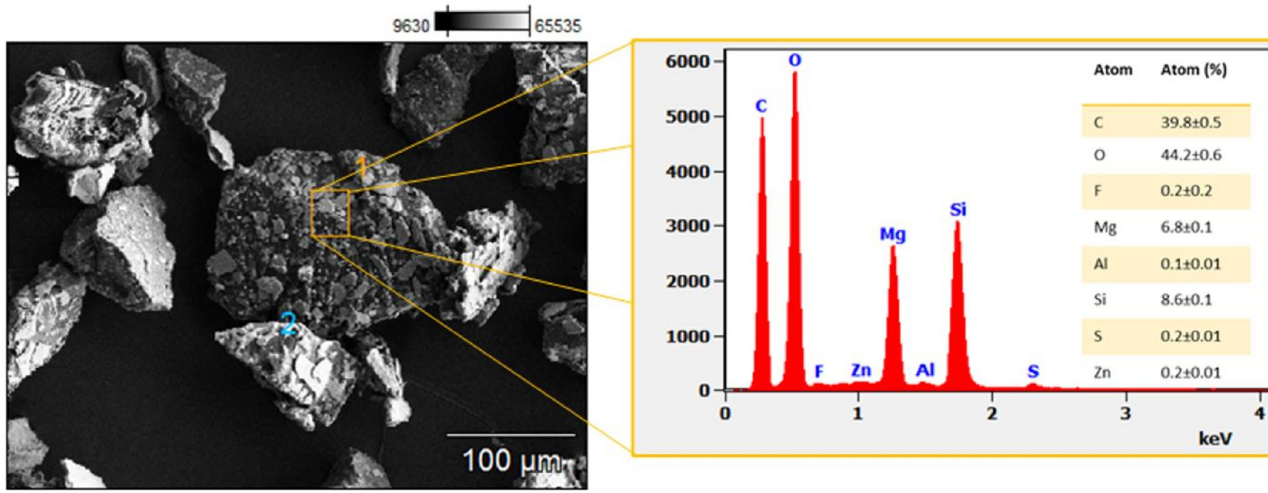
Figure 3. SEM micrograph of TR microparticles surface and related EDX